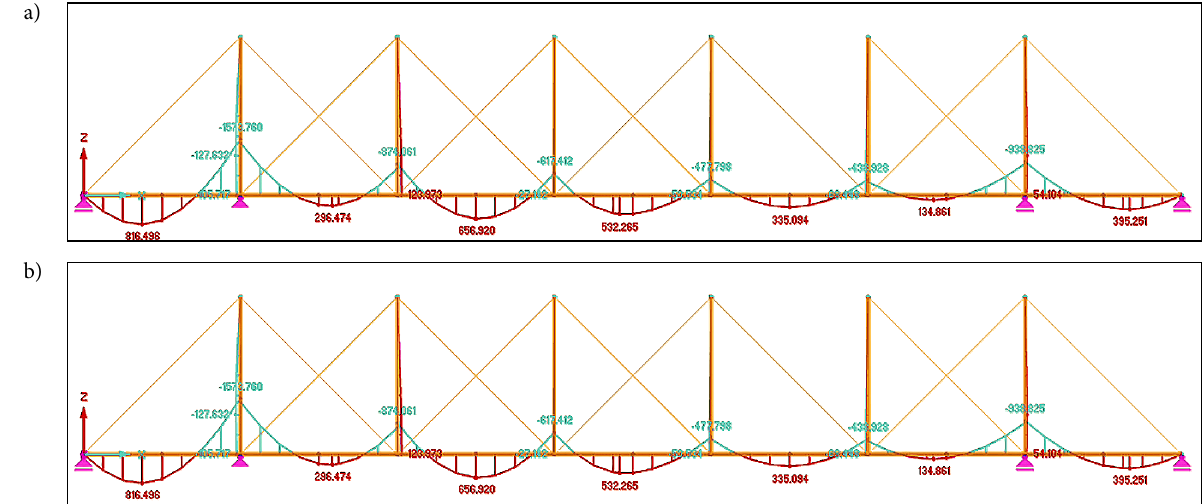
Figure 2. Equal pylons bridge. Bending moments: a) under symmetrical loading; b) under asymmetrical loading